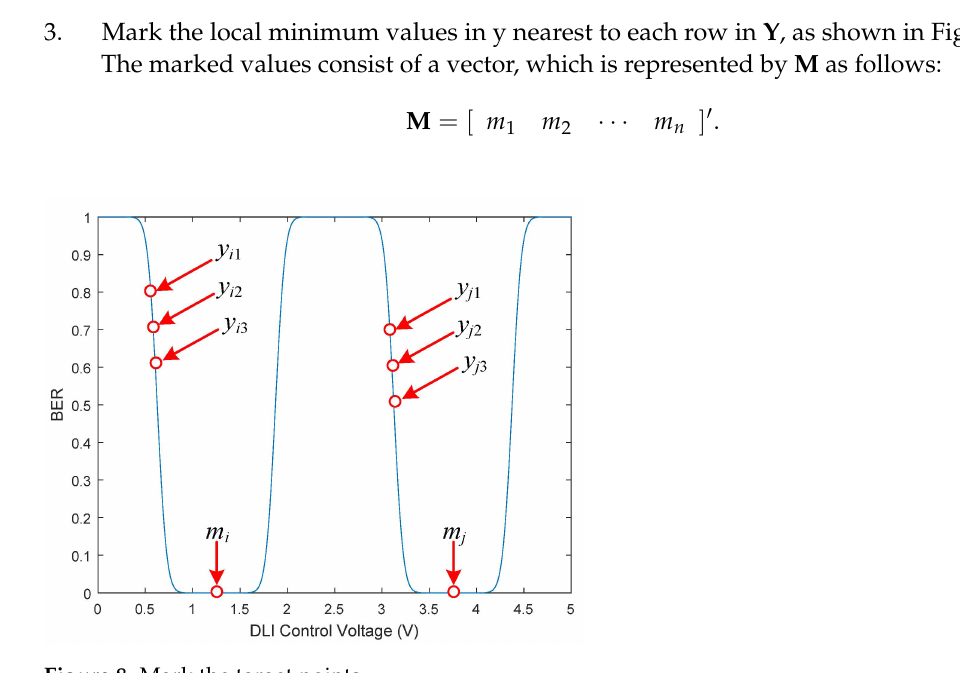
Figure 8. Mark the target points.